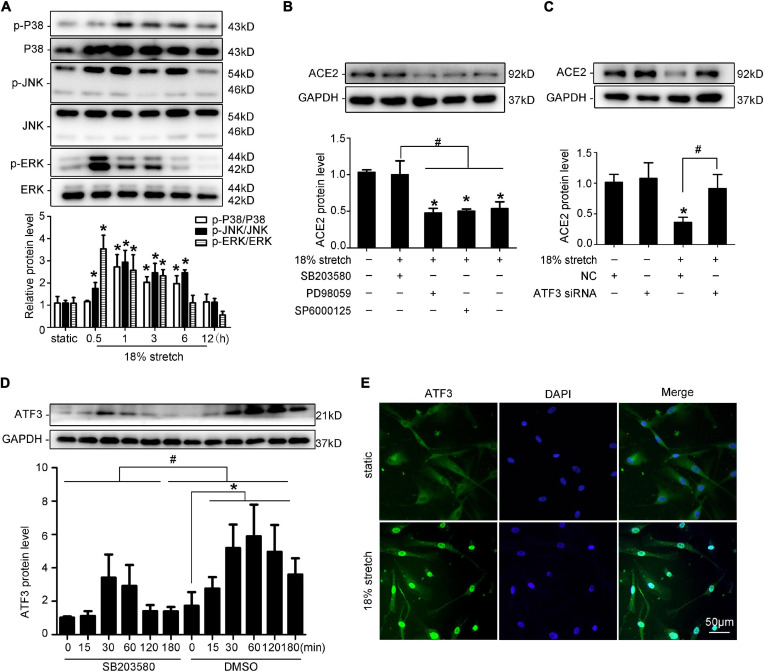
p38 MAPK/ATF3 is involved in ACE2 expression in vascular smooth muscle cells (VSMCs) under 18% mechanical stretch. (A) Western blot analysis of the phosphorylation of MAPKs under 18% mechanical stretch for 0–12 h. *P < 0.05 vs. static group. (B) Western blot analysis of ACE2 in VSMCs under mechanical stretch pretreated with SB203580, SP600125, or PD98059. *P < 0.05 vs. static control. #P < 0.05 vs. 18% stretch control. (C) Western blot analysis of ACE2 in VSMCs under 18% stretch or not after transfecting with negative control or ATF3 siRNA. *P < 0.05 vs. NC group, #P < 0.05 vs. 18% stretch with NC group. (D) Western blot analysis of ATF3 in VSMCs under 18% mechanical stretch with or without pretreatment of SB203580. (E) Immunofluorescence using anti-ATF3 was performed under stretch or not.